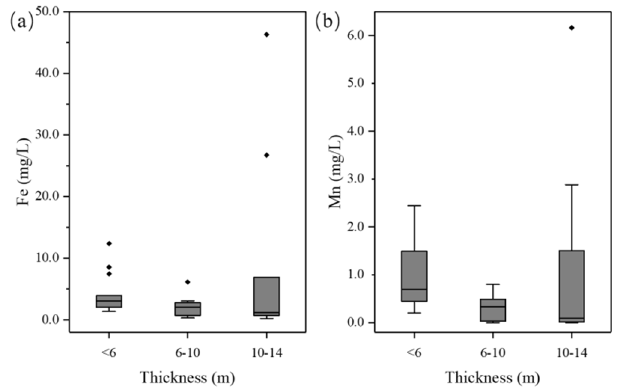
Figure 4. Boxplot of sample well clay thickness and Fe ( a ) and Mn ( b ) content (in the river valley).